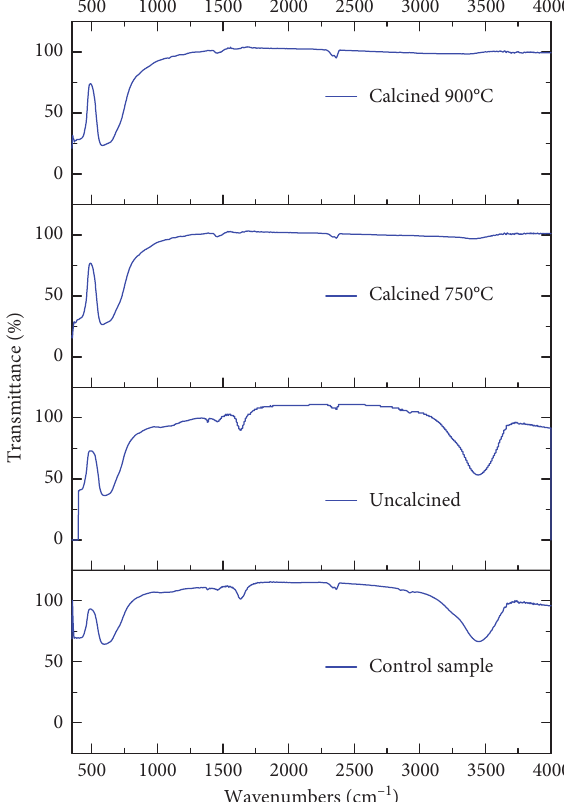
Figure 4: IR spectra of calcined and uncalcined tausonite